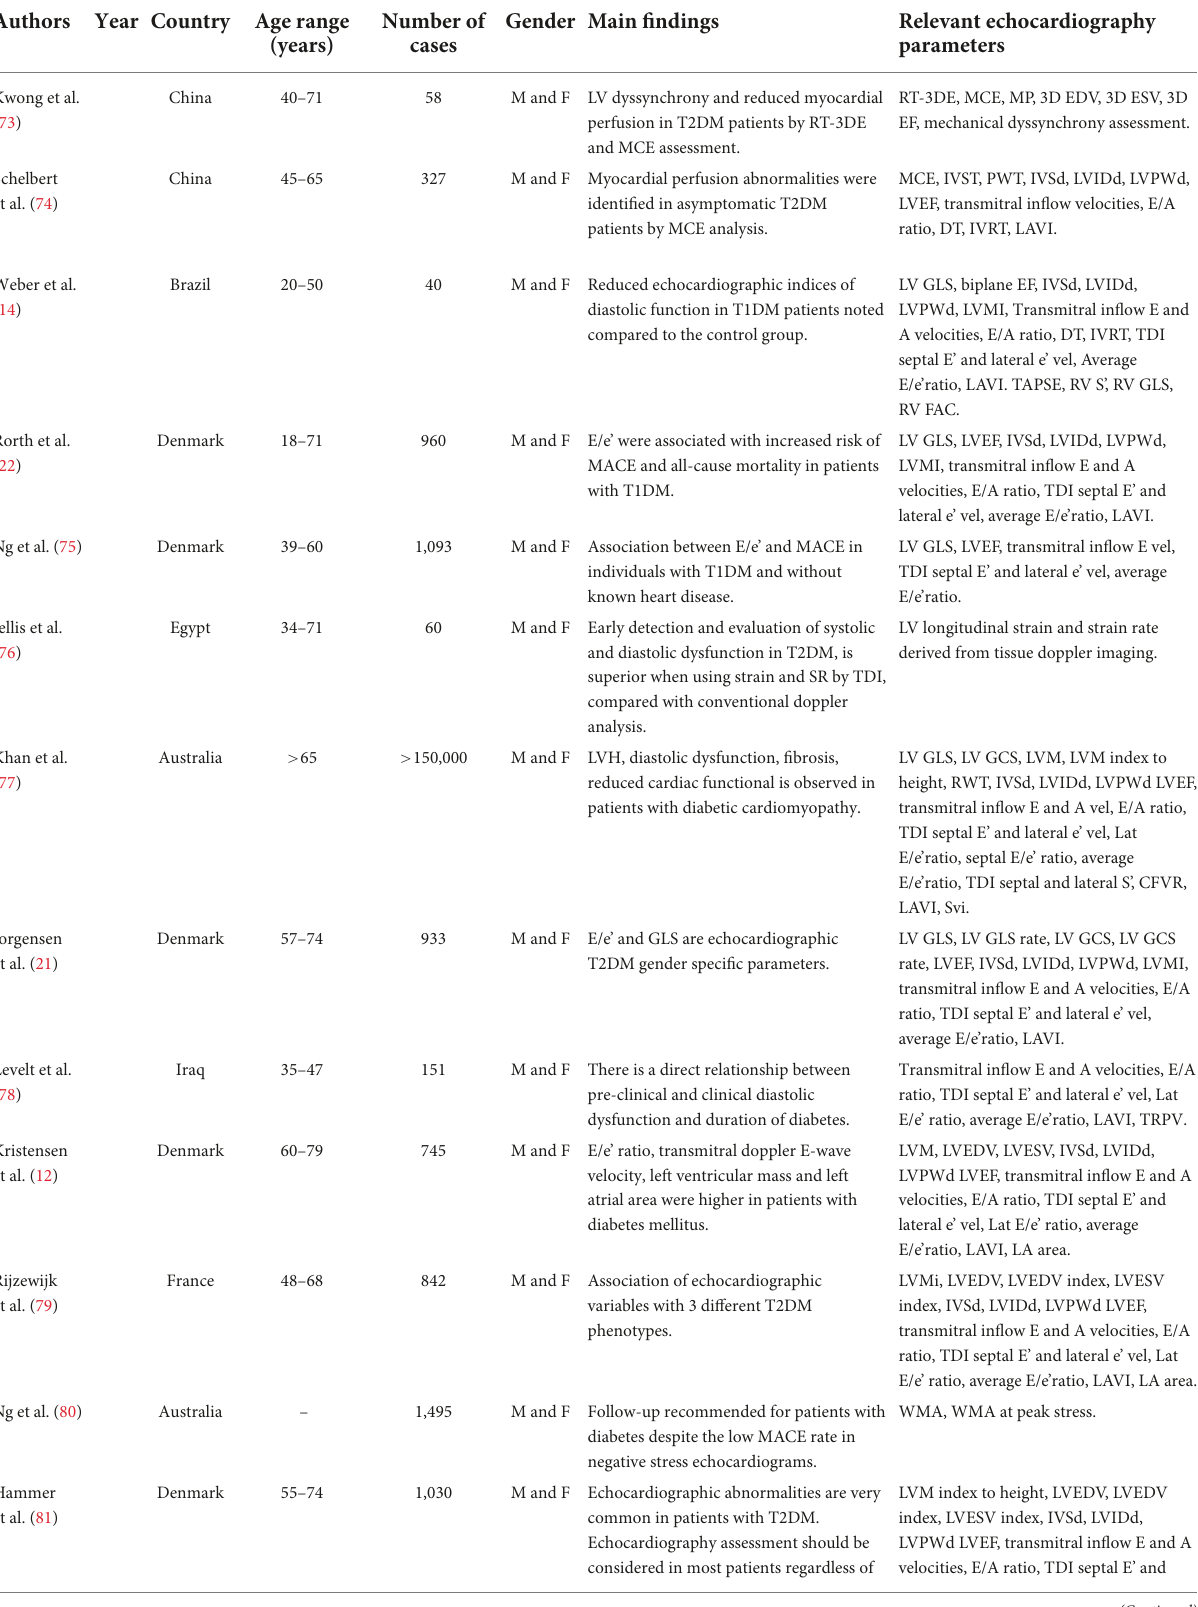
TABLE 1 Summary of studies assessing the role of echocardiography in the diagnosis of diabetic cardiomyopathy. Authors Year Country Age range